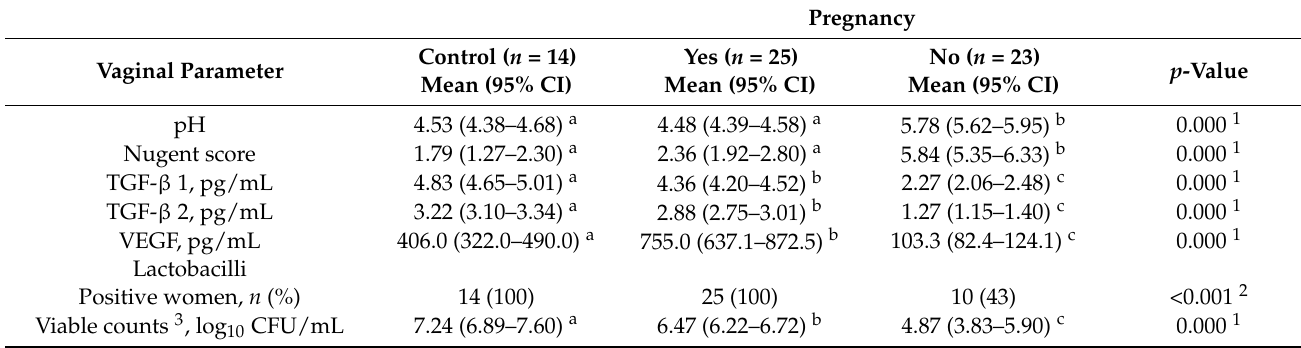
Table 7. Comparison of vaginal parameters (pH, Nugent score, TGF- β 1, TGF- β 2, and VEGF concentrations, and Lactobacillus counts) of all women who were able to complete a full-term pregnancy ( n = 25) and of those who did not ( n = 19) among all women with a history of repetitive abortion and with infertility of unknown origin (RA and INF groups) after the probiotic intervention with L. salivarius CECT5713 and vaginal parameters of fertile women (Control group; n = 14).